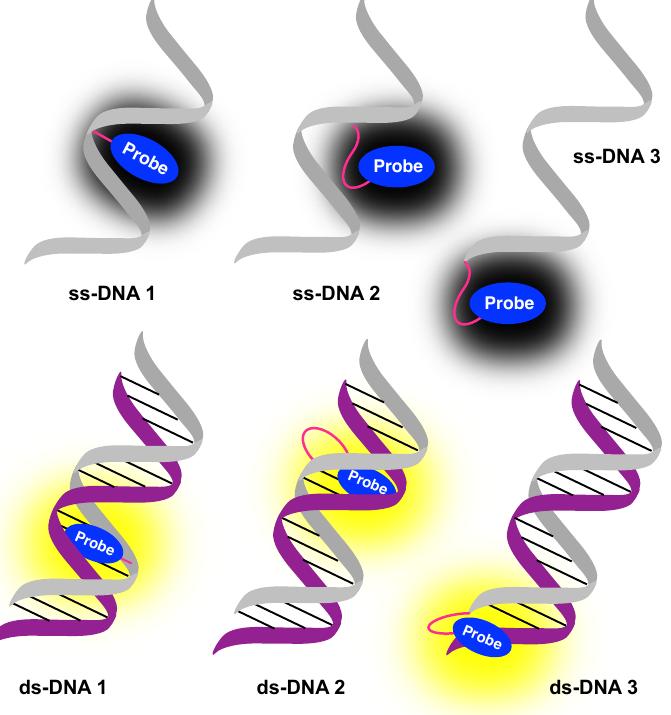
Figure 1. Schematic representation of the three ways to fluorescently label ODNs ( ss-DNA 1–3 ) and turn on their emission upon hybridization ( ds-DNA 1–3